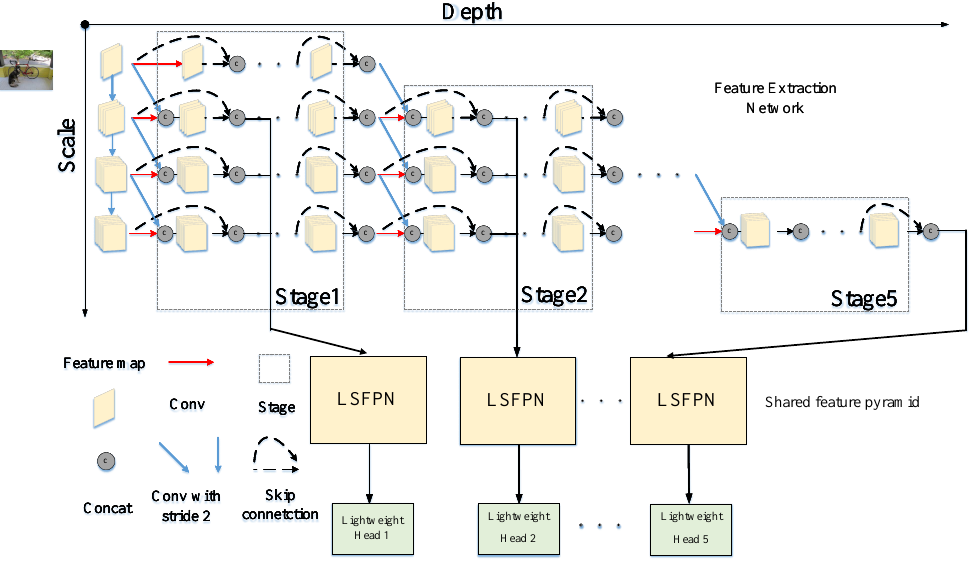
Figure 1. The overall network architecture diagram of the dynamic object detection